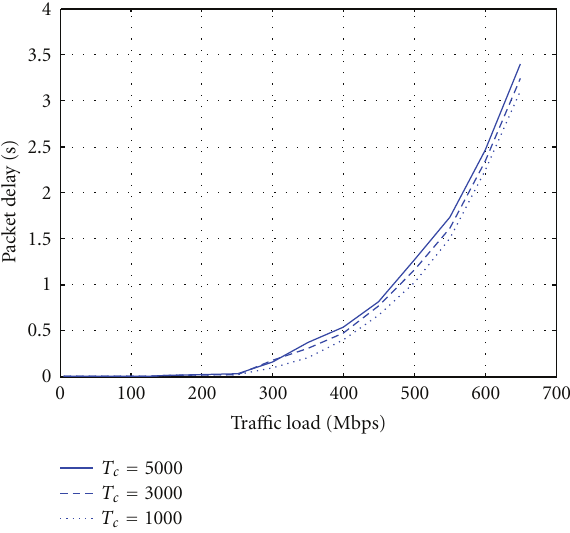
Figure 10: Mean packet delay versus tra ffi c load of the proposed algorithm.